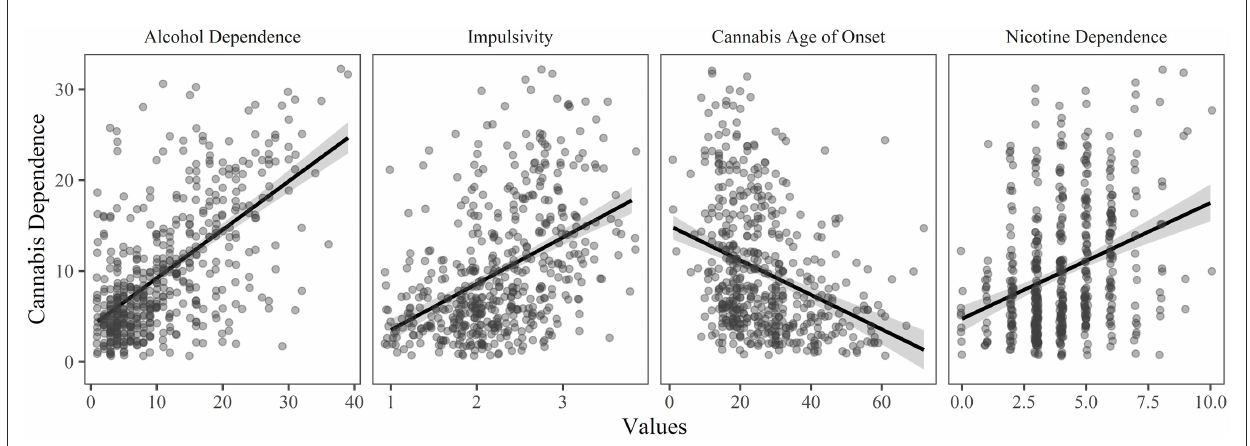
FIGURE2 The relationship between cannabis dependence and each of the significant predictor variables ( p < 0.05 and relative importance ≥ 0.02) in the final model of the hierarchical regression, holding all other variables constant.